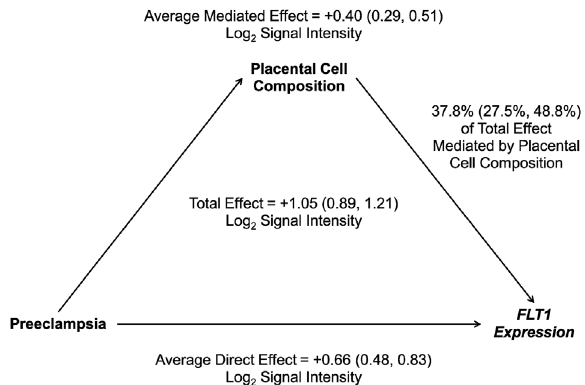
Fig. 6 Placental cell composition as a mediator of FLT1 expression. Mediation of FLT1 gene expression by placental cell type composition ( n = 157 cases, 173 controls). Placental cell composition was operationalized as fi rst fi ve principal components of estimated cell type proportions. 95% con fi dence intervals are provided after effect estimates for each model parameter. The same framework was also applied with LEP or ENG expression as the